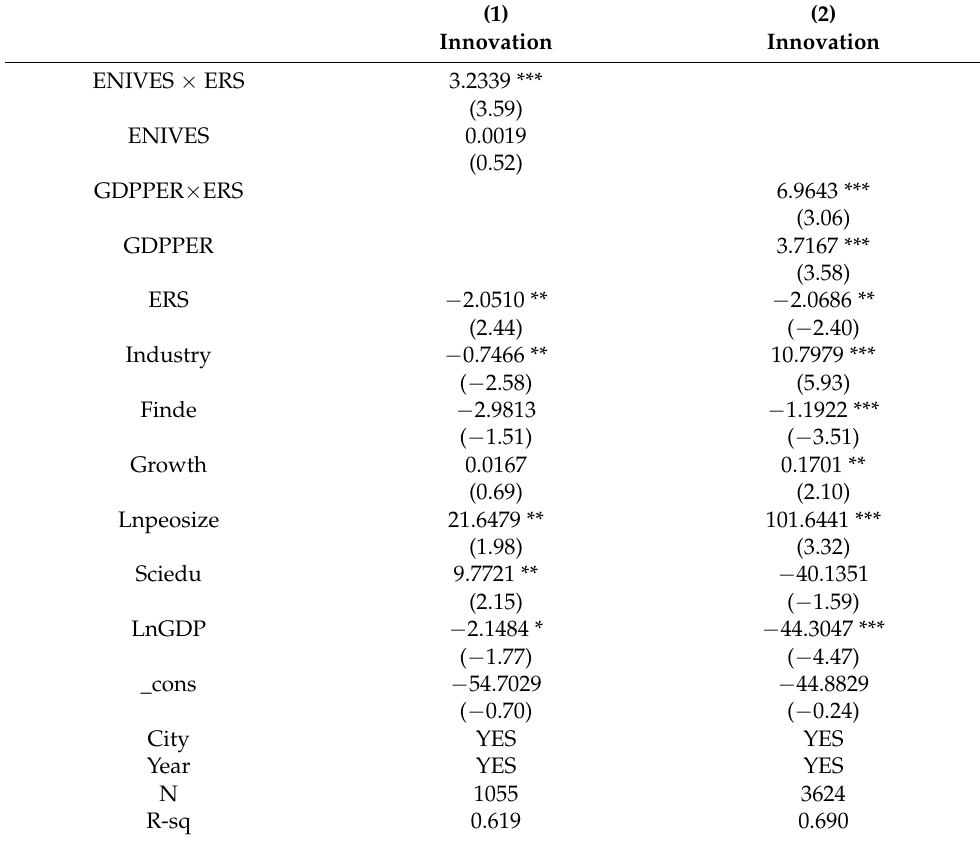
Table 14. Moderating effects of regional economic development and